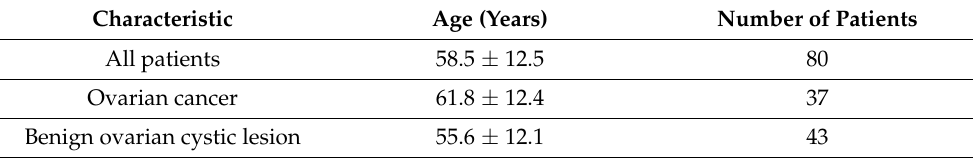
Table 2. Mean age of the patients